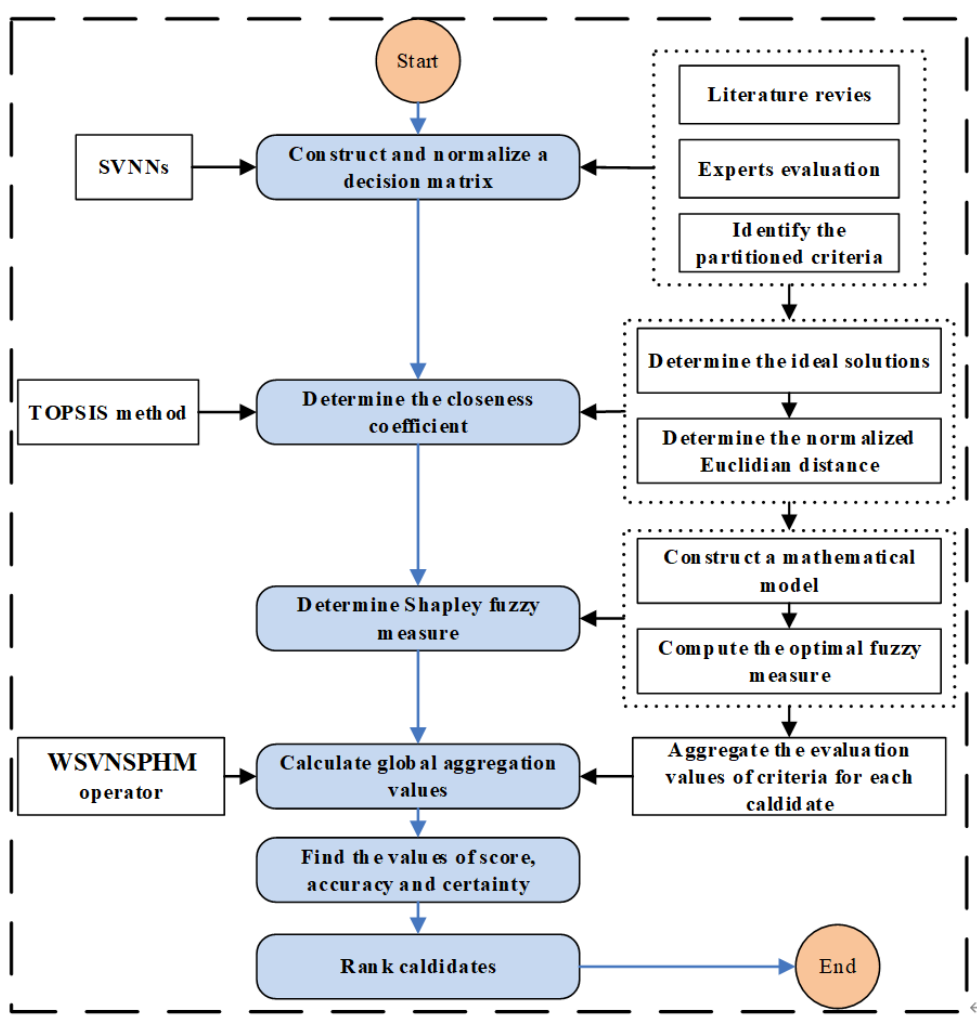
Figure 1. The flowchart of the proposed method.